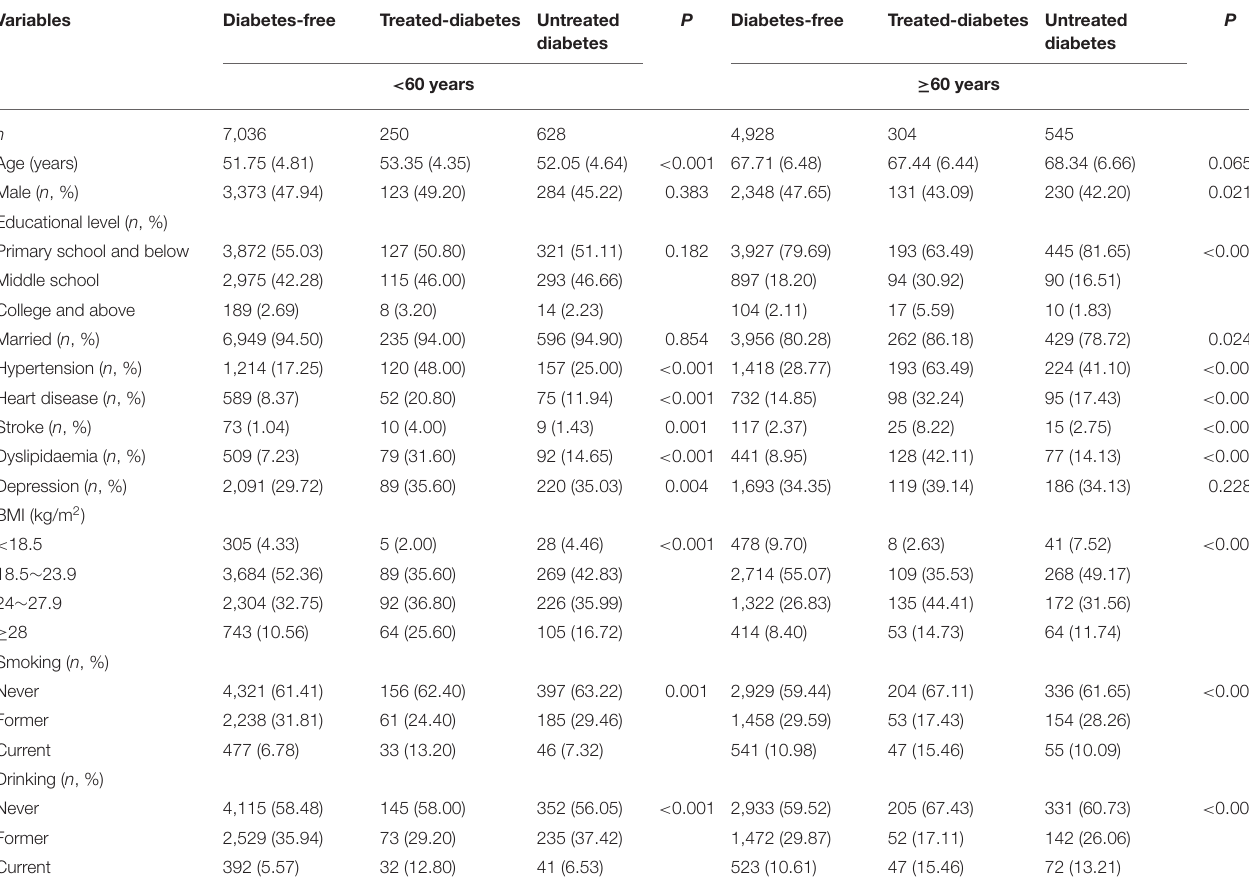
TABLE 1 | Characteristics of the study population among two age groups. Variables Diabetes-free Treated-diabetes Untreated